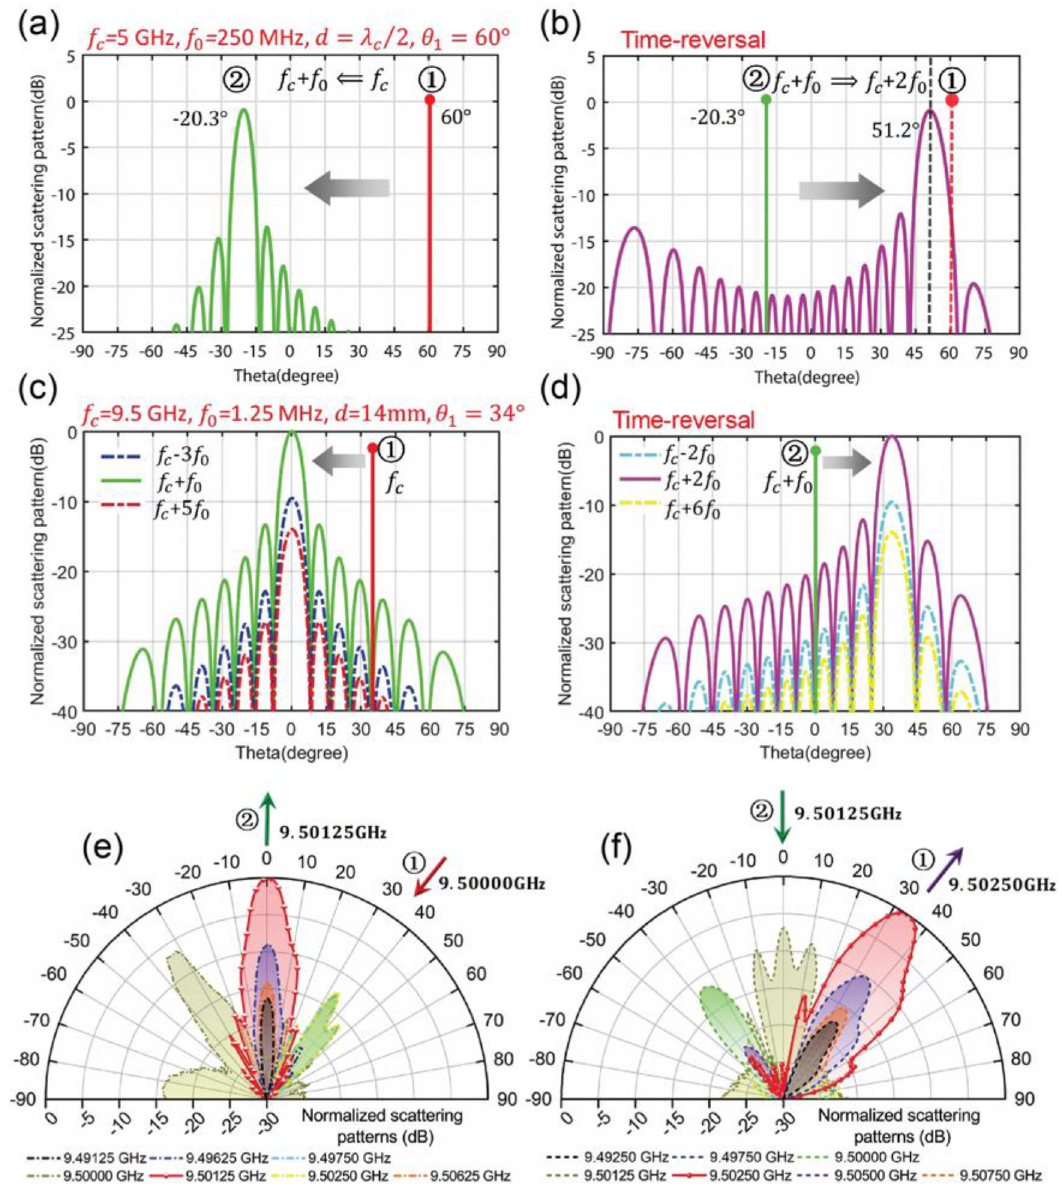
Fig. 3. Nonreciprocal re fl ection effects (adapted from [30]). (a, b) Numerically computed scattering patterns (forward-incidence and time-reversal channel, respectively) for the dominant harmonic orders, by assuming f c = 5 GHz, f 0 = 250MHz, d ¼ l c = 2 and u 1 =60 ° . (c, d) Same as above (but including higher-order harmonics) for a more realistic parameter con fi guration featuring f c = 9.5 GHz, f 0 = 1.25 MHz, d = 14 mm and u 1 = 34 ° . (e, f) Corresponding measured